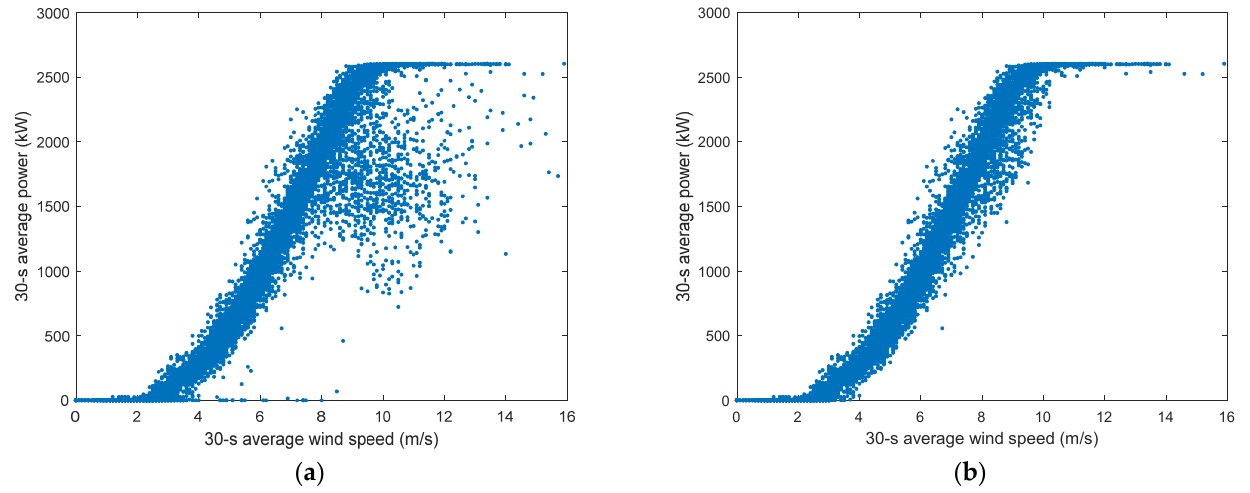
Figure 6. Scatterplots of wind speed vs. active power using ( a ) raw data and ( b ) cleaned data.